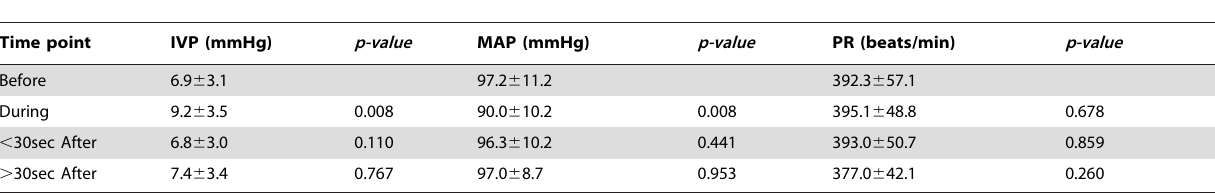
Table 2. Changes of the intraventricular pressure, mean arterial pressure, and pulse rate due to bilateral common jugular venous clipping.